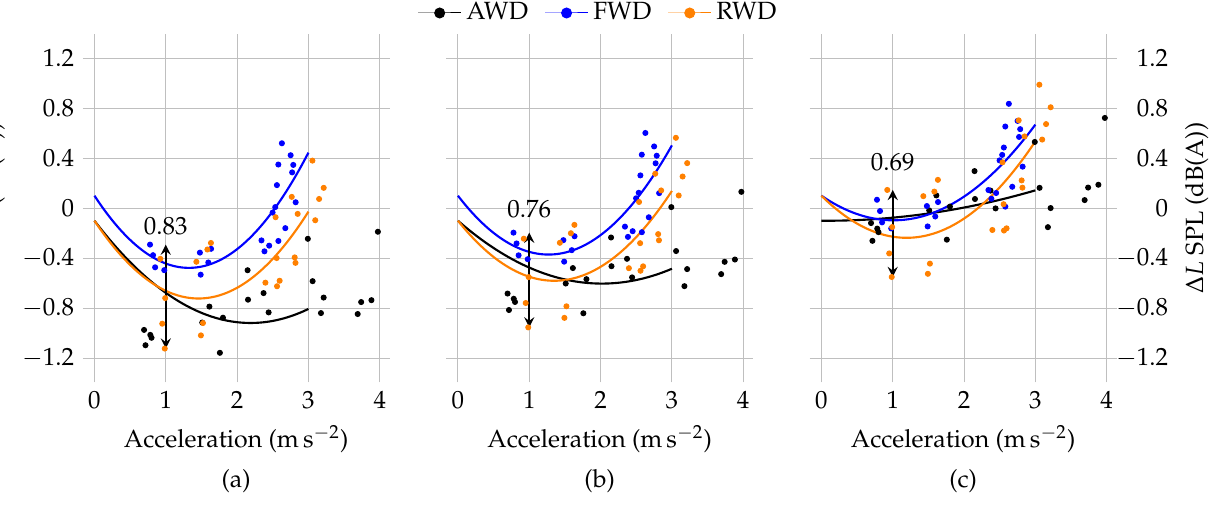
Figure 6. Impact of different temperature corrections on acceleration induced tire noise of one tire at point P-P’ on the left microphone. ( a ) Original 255P on LSBEV; ( b ) Norm Correction 255P on LSBEV; ( c ) MB-Correction 255P on